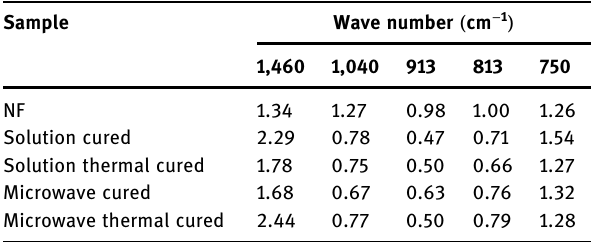
Table 1: IR relative intensity values of functional groups of phenolic epoxy fi